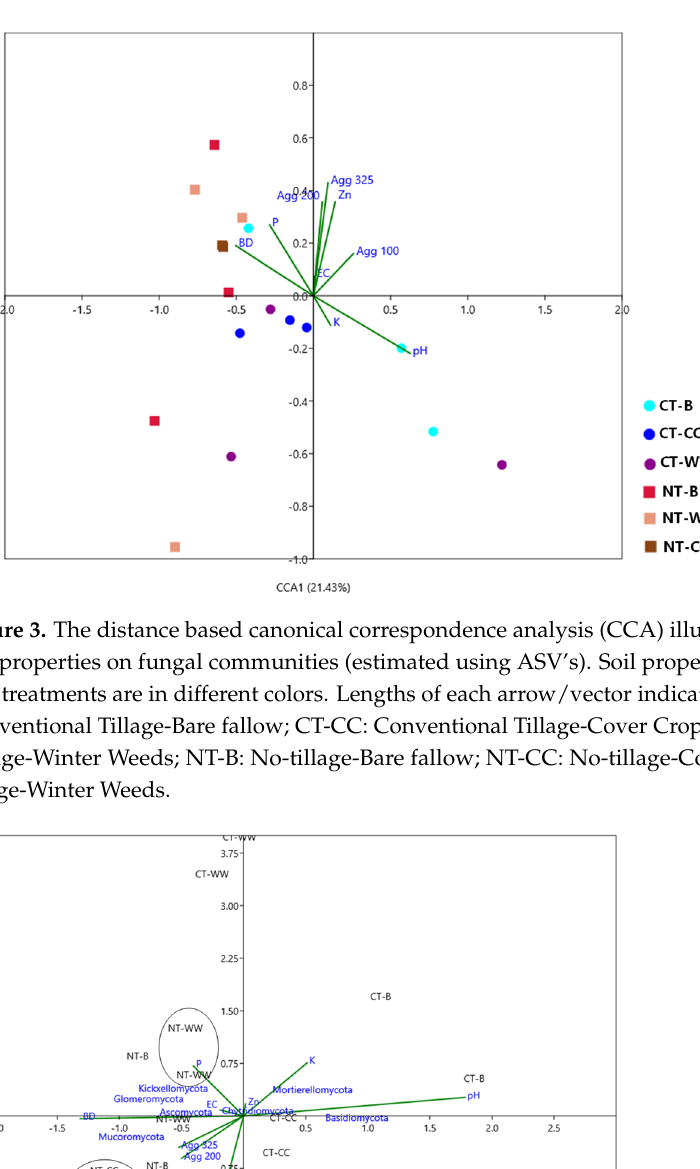
clusters were associated with soil test P and EC and the abundance of Glomeromycota and Kickxellomycota (Figure 4). In addition, the Mantel test was used to calculate correlations between corresponding positions of fungal community composition and soil property distance matrices. Overall, soil pH was significantly correlated ( p = 0.014) with the relative abundances of fungal phyla (Table 4).